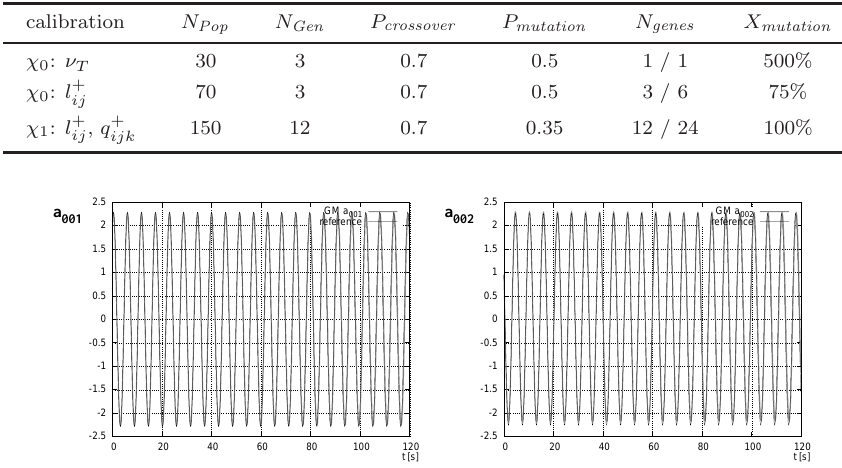
Figure 10. Two-equation Galerkin model with “eddy” viscosity calibration.